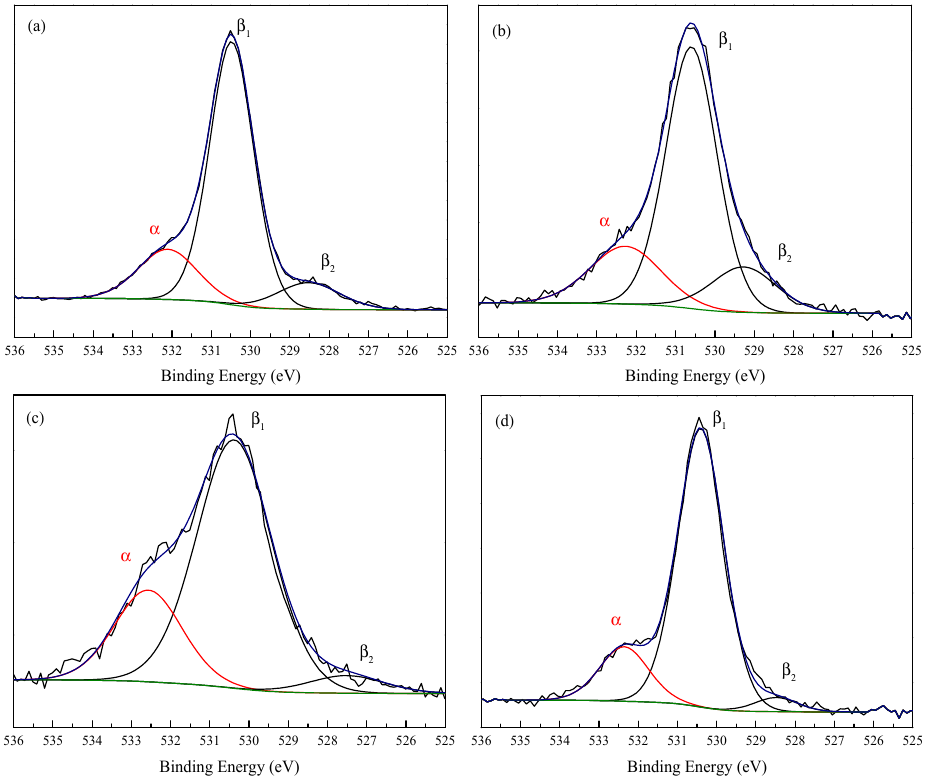
Figure 6. XPS profiles and fitting curves of O 1s peaks: RuO 2 /TiO 2 -r of ( a ) 0.3, ( b ) 0.5, ( c ) 1.0 wt% Ru, Table 1. Chemisorbed oxygen (O α ) in the RuO 2 /TiO 2 catalysts. RuO 2 /TiO 2 -a of ( d ) 0.5 wt%